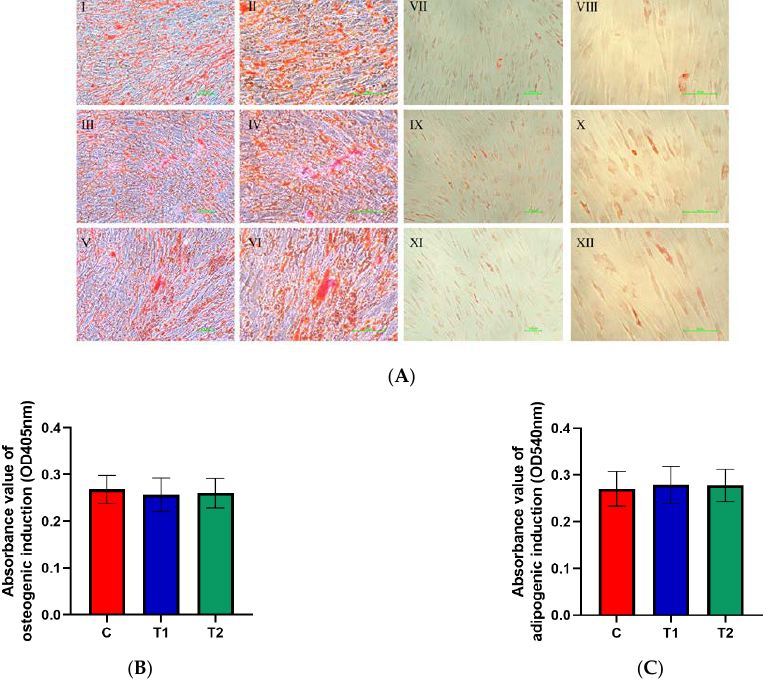
Figure 6. Differentiation potential of dental pulp cells. ( A ) Osteogenic and adipogenic differentiation results of dental pulp cells. Ⅰ – Ⅵ : Osteogenic differentiation results. Ⅰ : C group (×40); Ⅱ : C group (×100); Ⅲ : T1 group (×40); Ⅳ : T1 group (×100); Ⅴ : T2 group (×40); Ⅵ : T2 group (×100). Ⅶ – Ⅻ : Adi- pogenic differentiation results. Ⅶ : C group (×40); Ⅷ : C group (×100); Ⅸ : T1 group (×40); Ⅹ : T1 group (×100); Ⅺ : T2 group (×40); Ⅻ : T2 group (×100). ( B ) The absorbance value at 450 nm of dis- solved solution after Alizarin Red S staining in the three groups. ( C ) The absorbance value at 540 nm of dissolved solution after Oil Red O staining in the three groups.